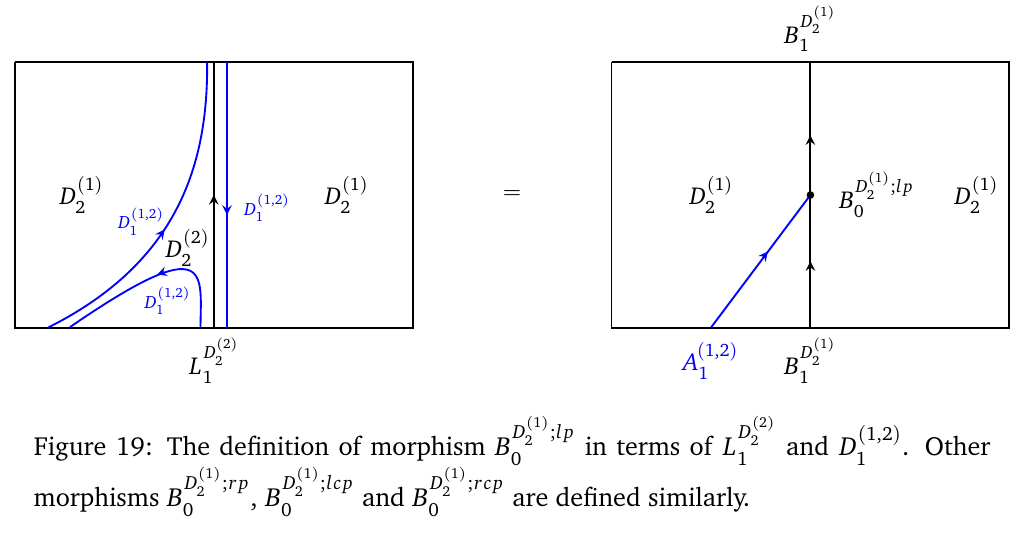
D p 1 q D p 1 q ; rp ; lcp 2 2 , B and B 0 0